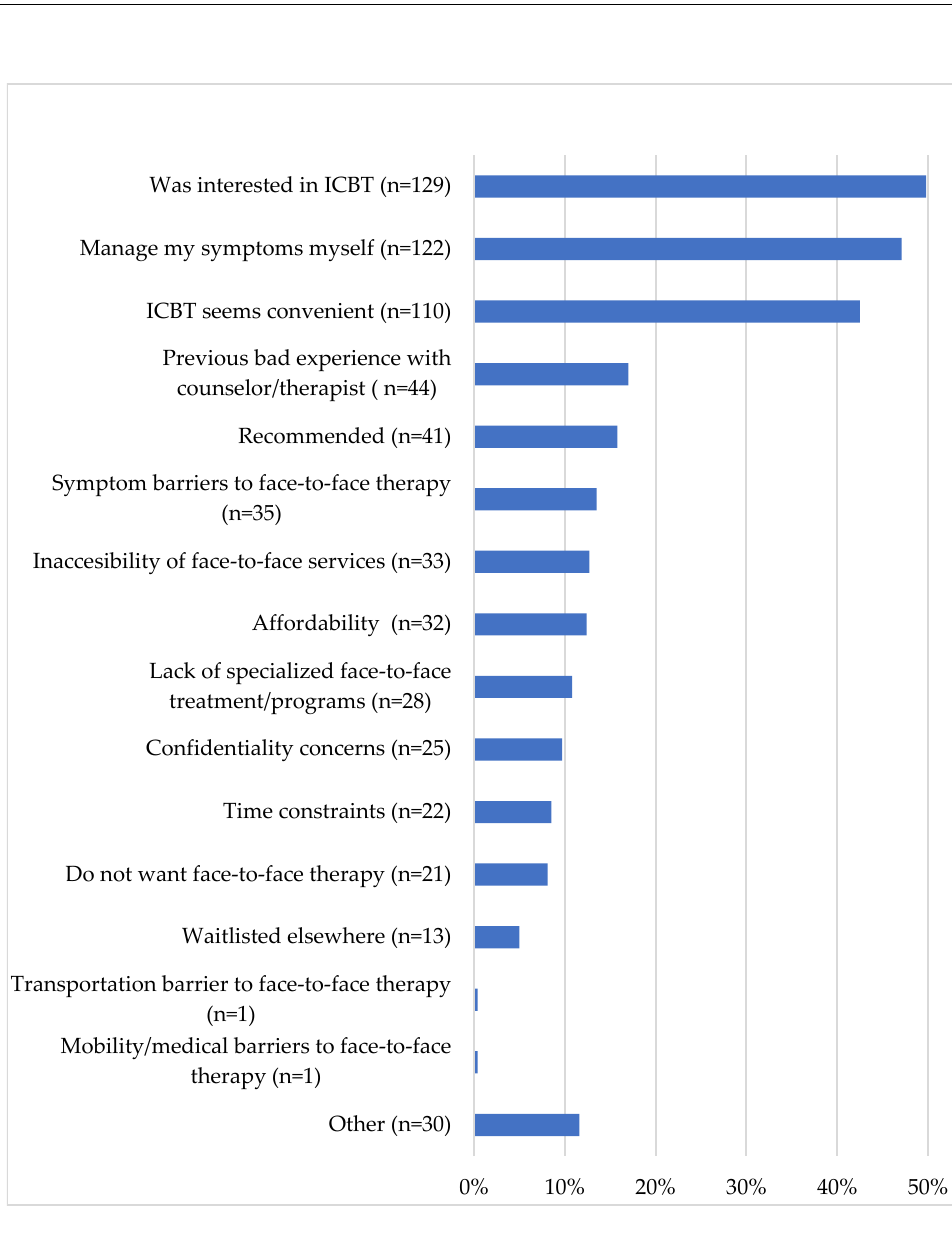
Figure 3. Reasons for seeking ICBT.